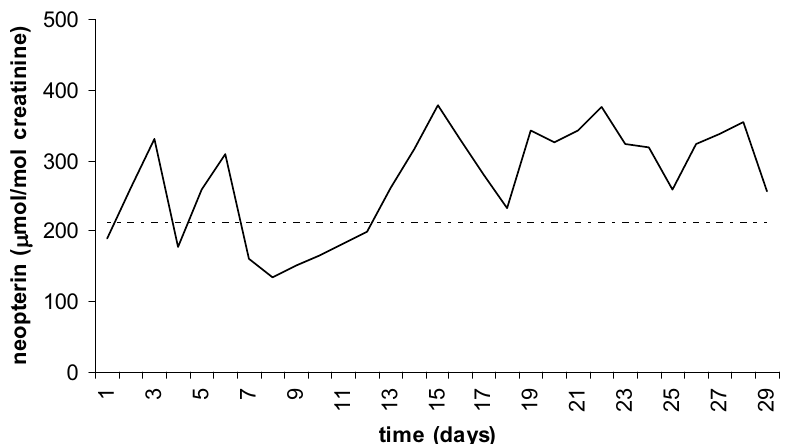
Figure 5. A 48-year-old woman with second recurrence of EOC was treated with the combination of paclitaxel (175 mg/m 2 ) and carboplatin (area under the curve 6) every 3 weeks that resulted in regression of ascites. The ini- tial urinary neopterin concentration was within the normal range. The administration of the second dose had to be postponed because of prolonged neutropenia until after the last measurement. Filgrastim (480 µ g subcuta- neously) was administered on days 10 - 12, resulting in a rise of urinary neopterin concentrations. Besides this peak, fluctuations of neopterin concentrations with peaks of few days' duration were observed during the first cycle. Serum CA125 was only mildly increased (128 U/ml) and decreased during the treatment (69 U/ml). The upper limit of normal urinary neopterin concentrations is indicated by dashed